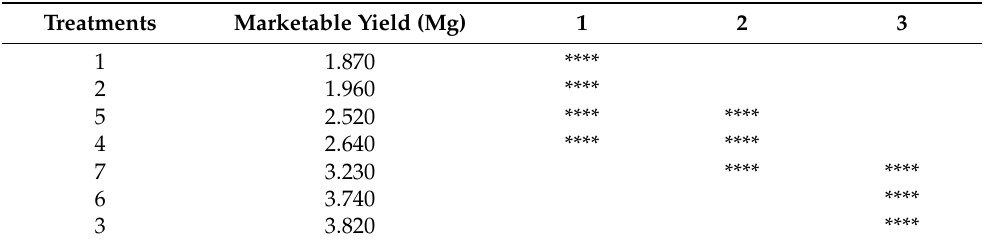
Table 7. The results of Tukey ’ s test for groups of significantly homogeneous grouping factor (****) of biochar dose and soybean yield.